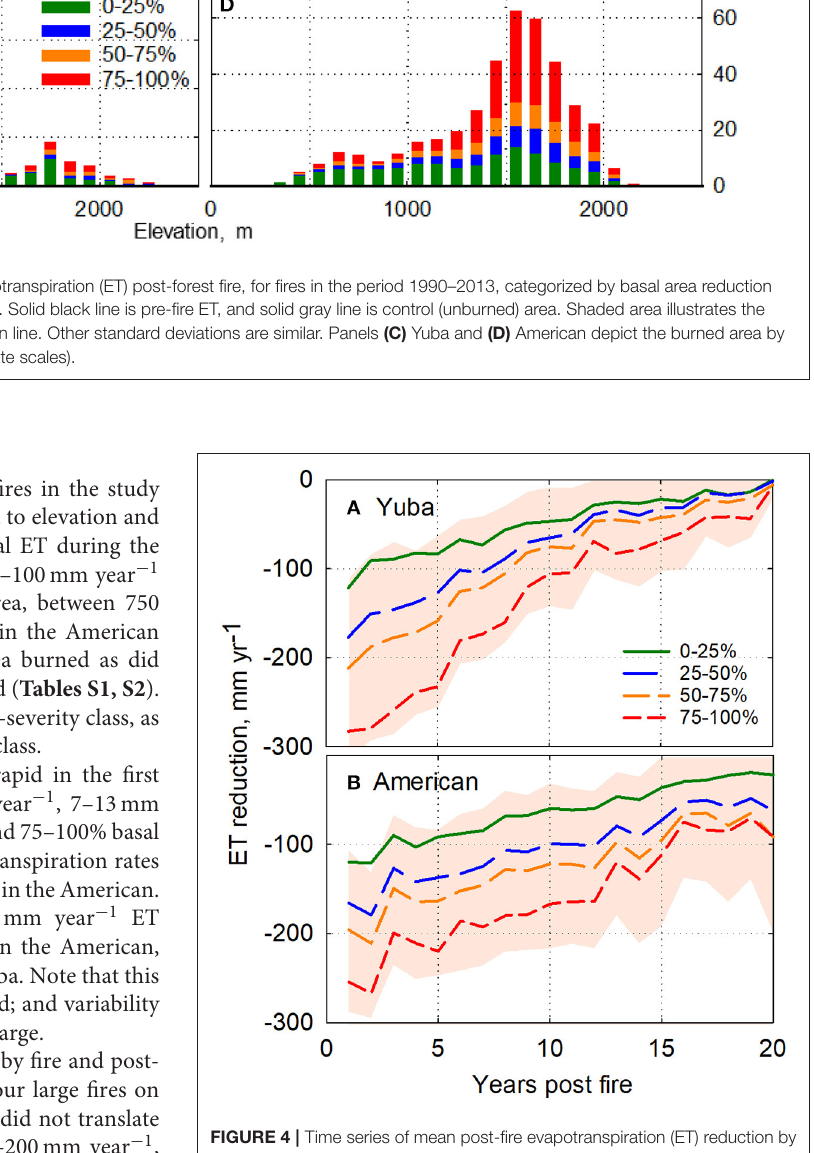
FIGURE 4 | Time series of mean post-fire evapotranspiration (ET) reduction by fire-severity class or post-fire response of ET, for the (A) Yuba and (B) American, 1990–2018. Plus and minus one standard deviation is shown for the 50–75% basal area-reduction class. Other standard deviations are